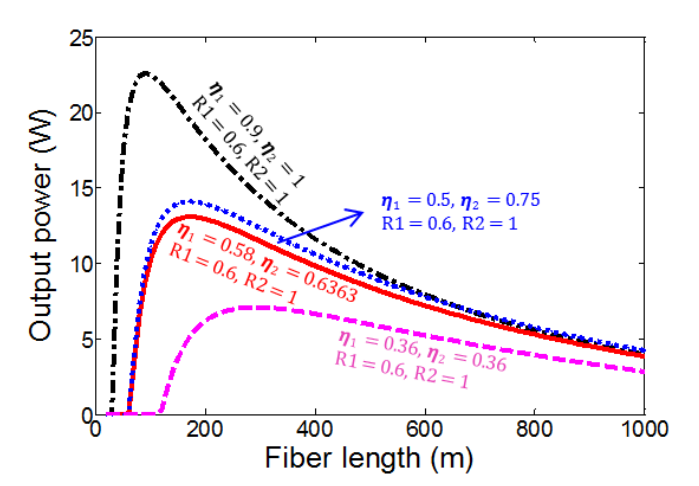
Figure 9. Simulation of output power vs. DCRF length at pump power of 65 W (launched) for different reflectivities of the output coupler (R1) and re-launch efficiencies ( η corresponds to out-coupling end and η 1